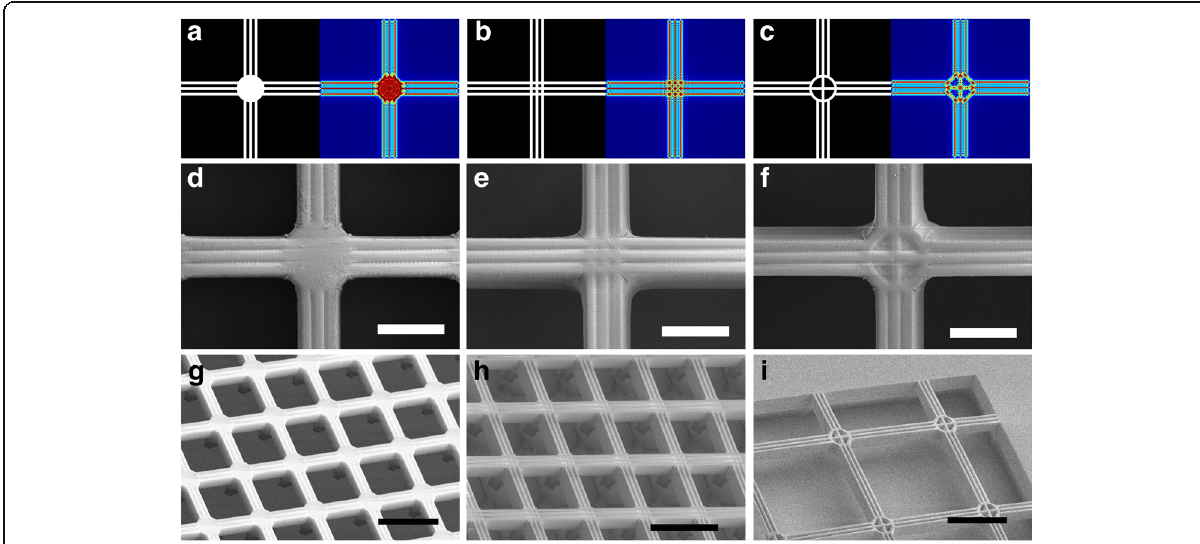
Fig. 5 Different cross connection patterns with NR26-25000P. a – c Three cross connection patterns on the mask and the corresponding simulation results at z = 15 μ m, where the line width is 2 μ m with spacing of 2 μ m and z is the distance between the section plane and photo mask. d – f The textures on the obtained photoresist cross connection and the broad beams, where the scale bars are 20 μ m. g The suspended meshes with supporting pillars. h The suspended meshes with thin supporting pillars, where the pillars result from the dense cross connection patterns with high ratio. i The full suspended mesh patterns. The scale bars in g – i are 100 μ m